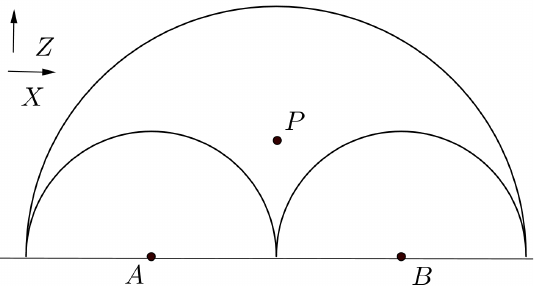
Figure 4 . It is not possible to reconstruct the bulk operator at P if we restrict to either subregion A or B . The reconstruction is however possible if bilocals from A ∪ B are